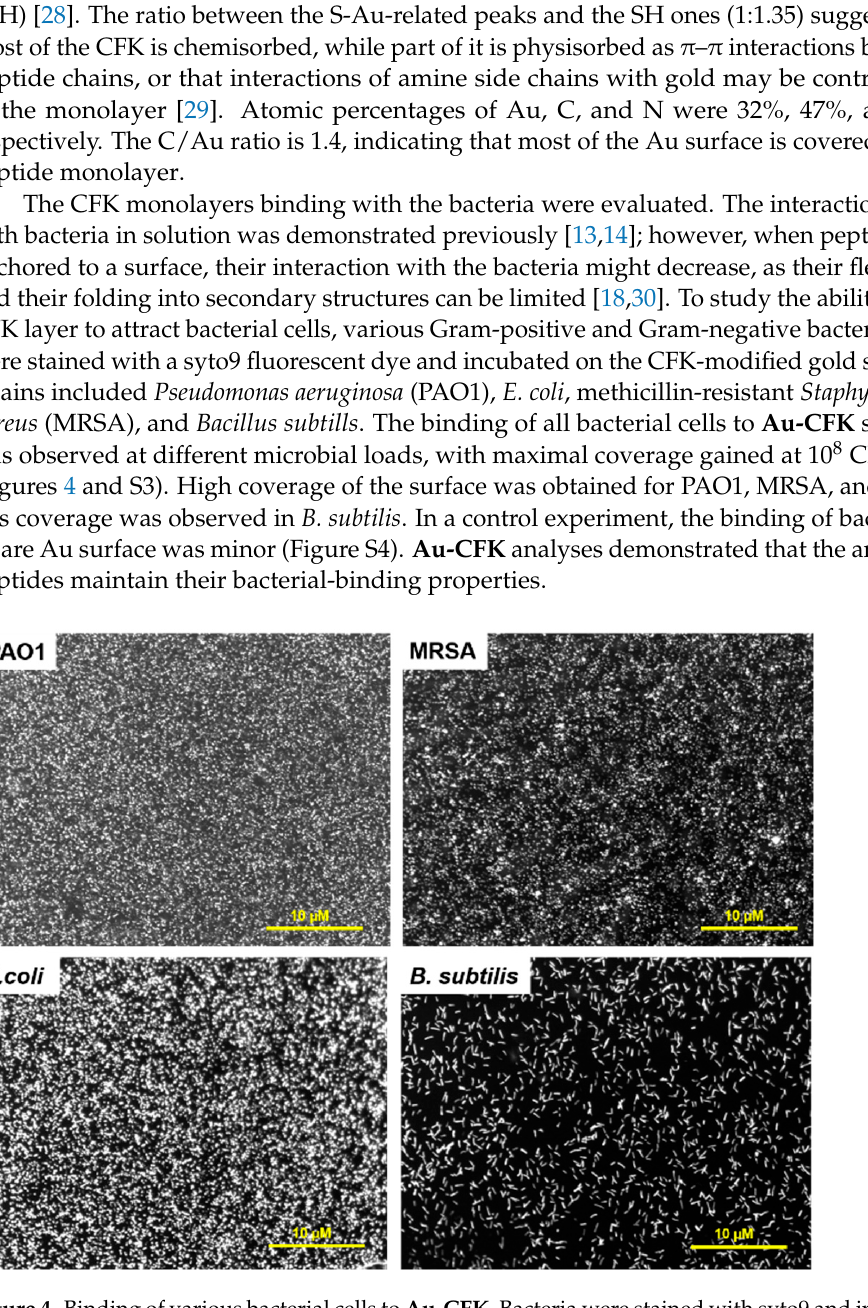
Figure 4. Binding of various bacterial cells to Au-CFK . Bacteria were stained with syto9 and incubated on FK-modified surface. The unbound bacteria were washed, and the surfaces were observed via a fluorescence microscope (×20 magnification).